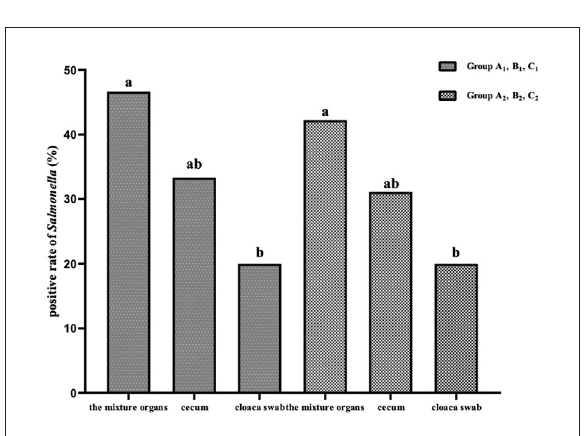
FIGURE4 The positive rates of Salmonella in different organs in the challenge-protection